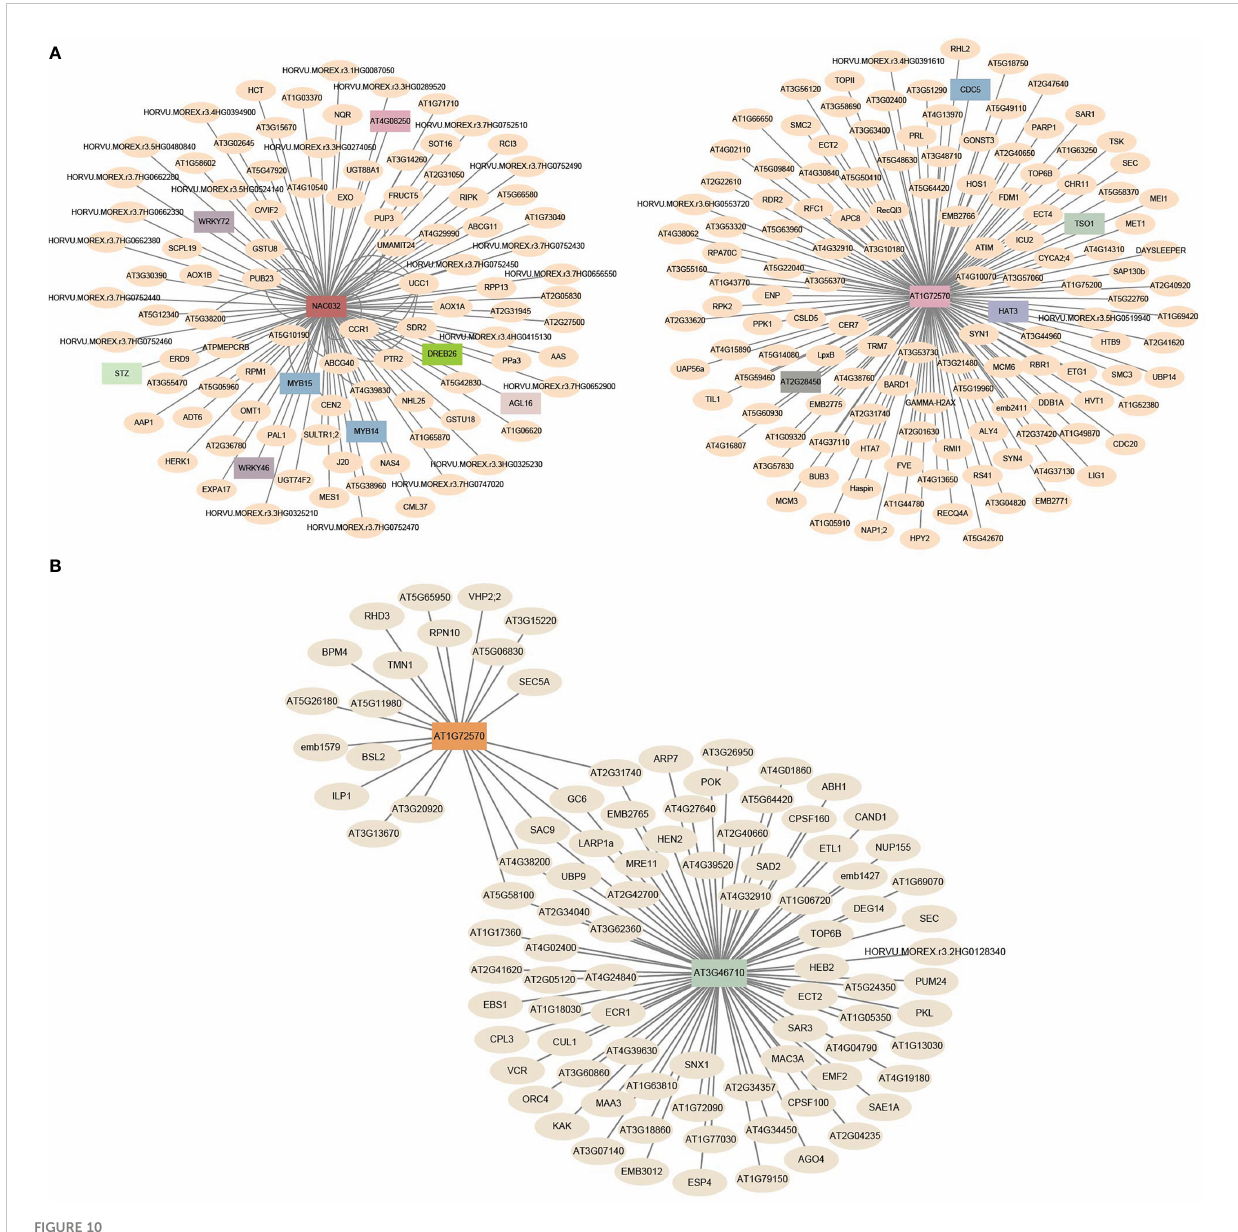
FIGURE 10 The co-expression network of expanded genes with other TF-type genes. (A) Co-expression network in different tissues/stages. (B) Co-expression network under different stresses. The barley genes were annotated with homologs of A.